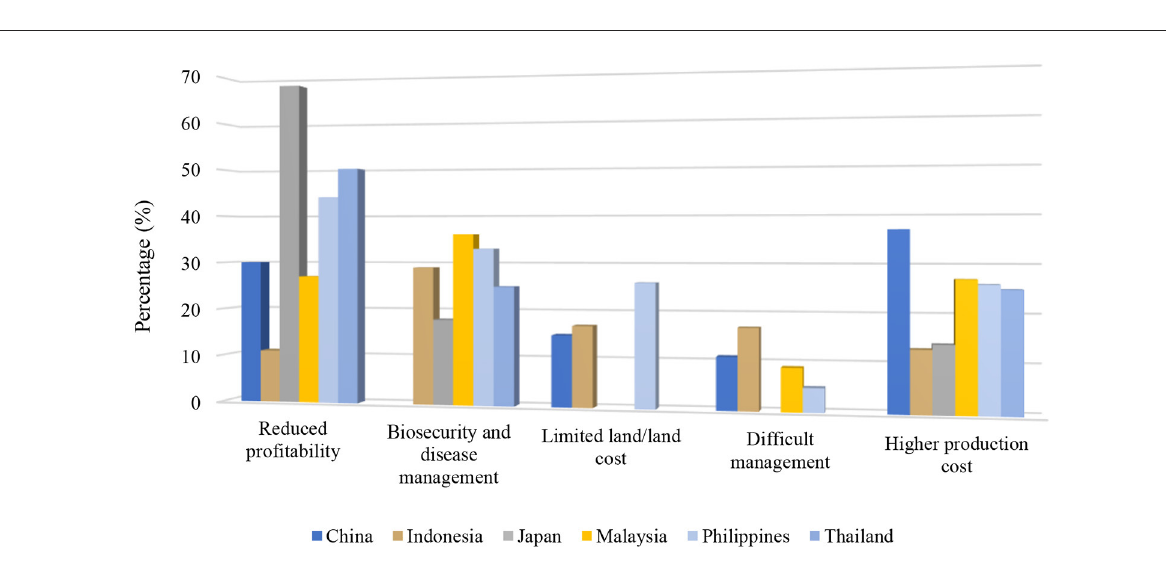
FIGURE4 Cage egg producers’ most frequently identified barriers to adopting cage-free systems displayed by